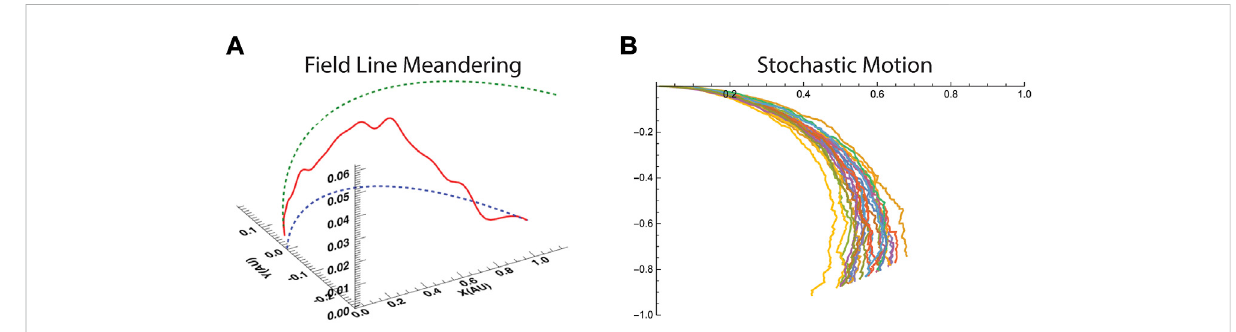
FIGURE 6 (A) Fieldlinemeandering(fromAshrafandLi,2019)and (B) stochasticmotion(fromBian andLi,2021)areimportantmechanismsthatcausethe location ofenergetic electrons reaching1 auto dramaticallydeviate from thenominalParkerSpiral. The relativecontributions ofthese processes on particle transport are unknown, but critical to understanding particle